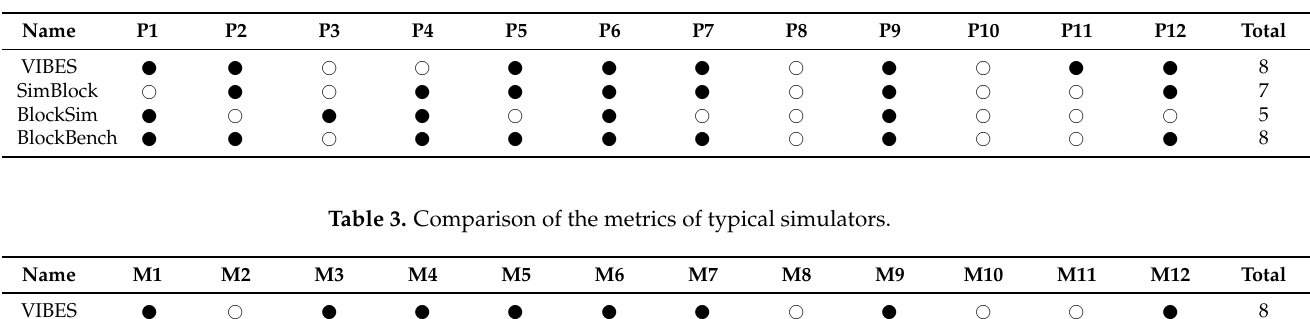
Table 2. Comparison of the parameters of typical simulators.